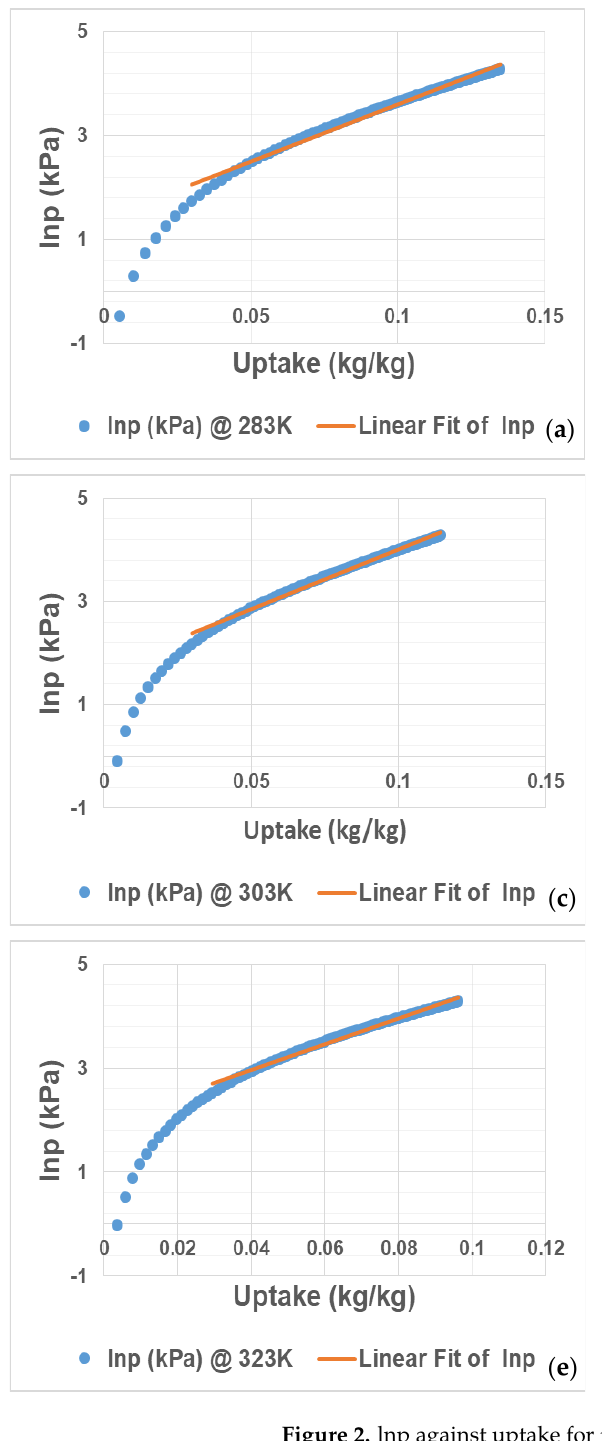
Figure 2. lnp against uptake for the adsorption isotherm on silica gel at 283 K – 333 K, with the linear fit at the estimated regions. ( a ) represent the linear fit at temperature 283 K, ( b ) represent the linear fit at 293 K, ( c ) represent the linear fit at 303 K, ( d ) represent the linear fit at 313 K, ( e ) represent the linear fit at 323 K, and ( f ) represent the linear fit at 333 K.